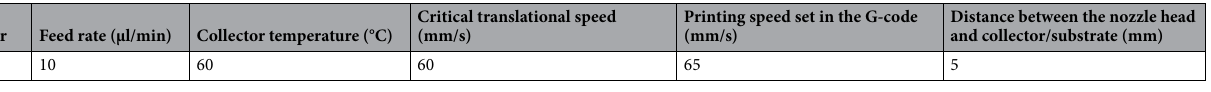
Table 1. Values of several parameters of the MEW process (equal for both PLA and